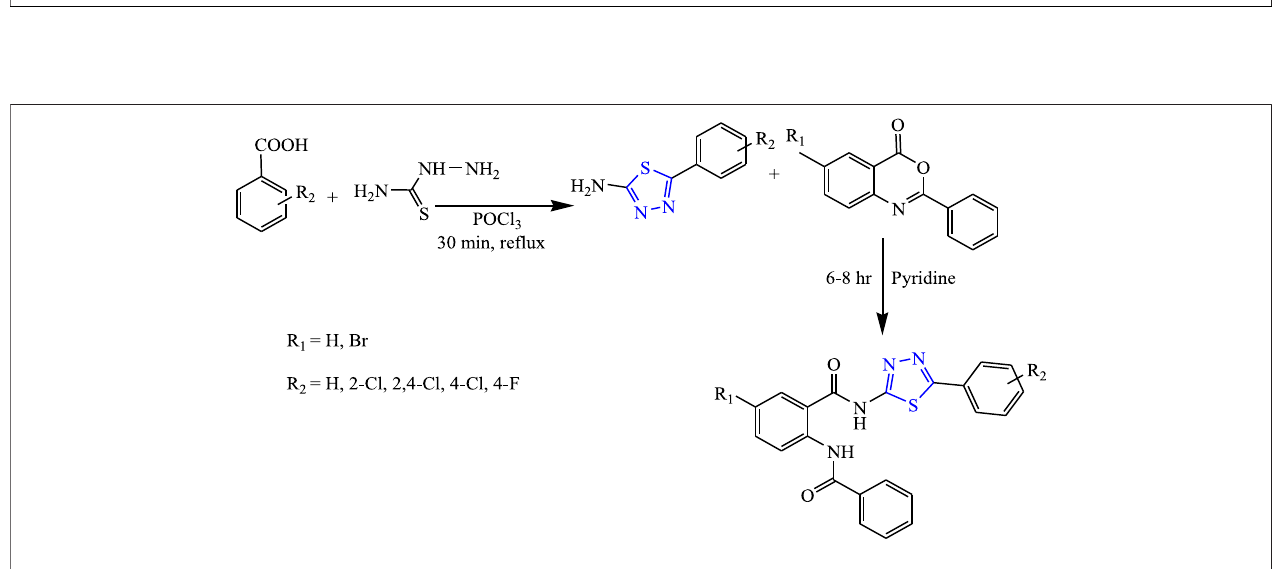
FIGURE 21 | Systematic scheme for synthesizing amino 1,3,4-thiadiazole analogs.